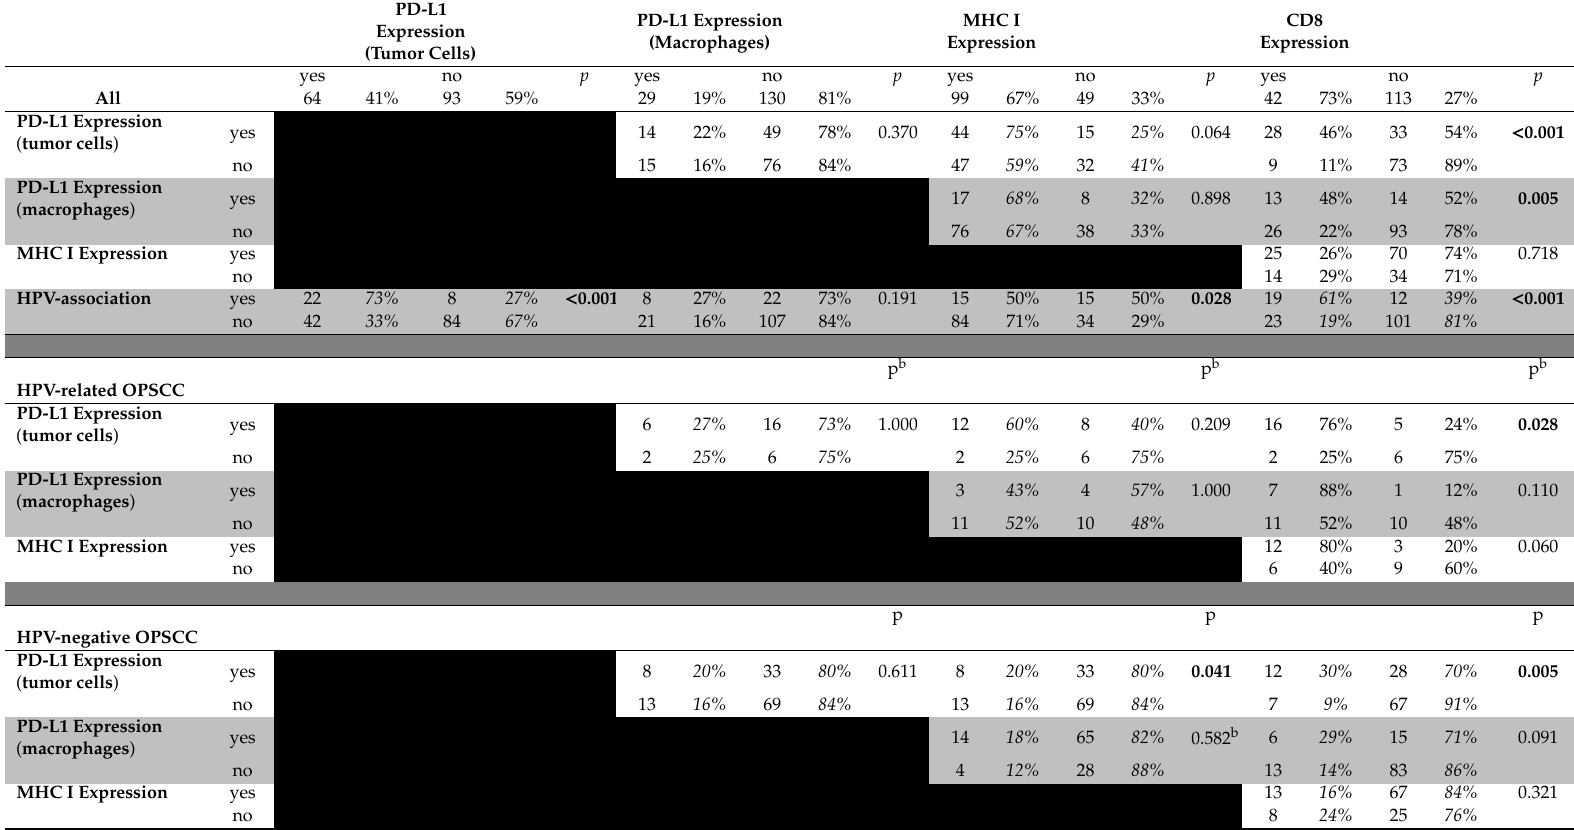
Table 2. Relation of PD-L1 (tumor cells and macrophages), MHC I expression and CD8 expression according to each other in the whole cohort and according to HPV-status ( n =